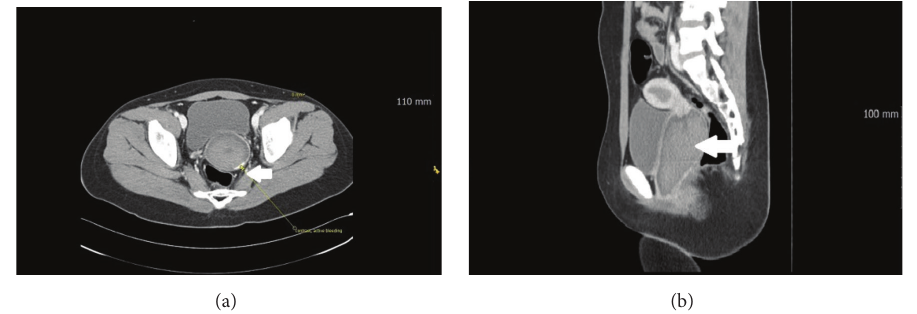
Figure 1: Computed tomographic findings. (a) Axial view. Arrow shows contrast extravasation and active bleeding in vagina. (b) Blood-filled vagina means hematocolpos in sagittal view.